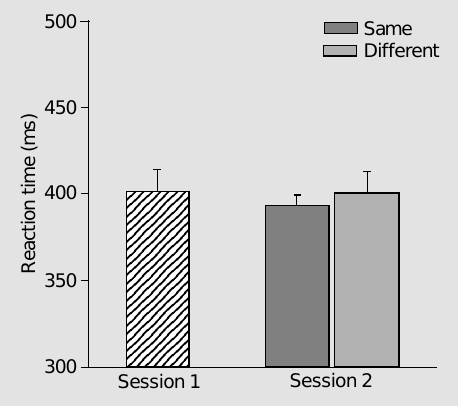
Figure 3. Mean reaction time (± SEM) of 12 participants to the cross inside the ring in the first testing session and at the same and different positions as S1 in the second testing session of Experiment